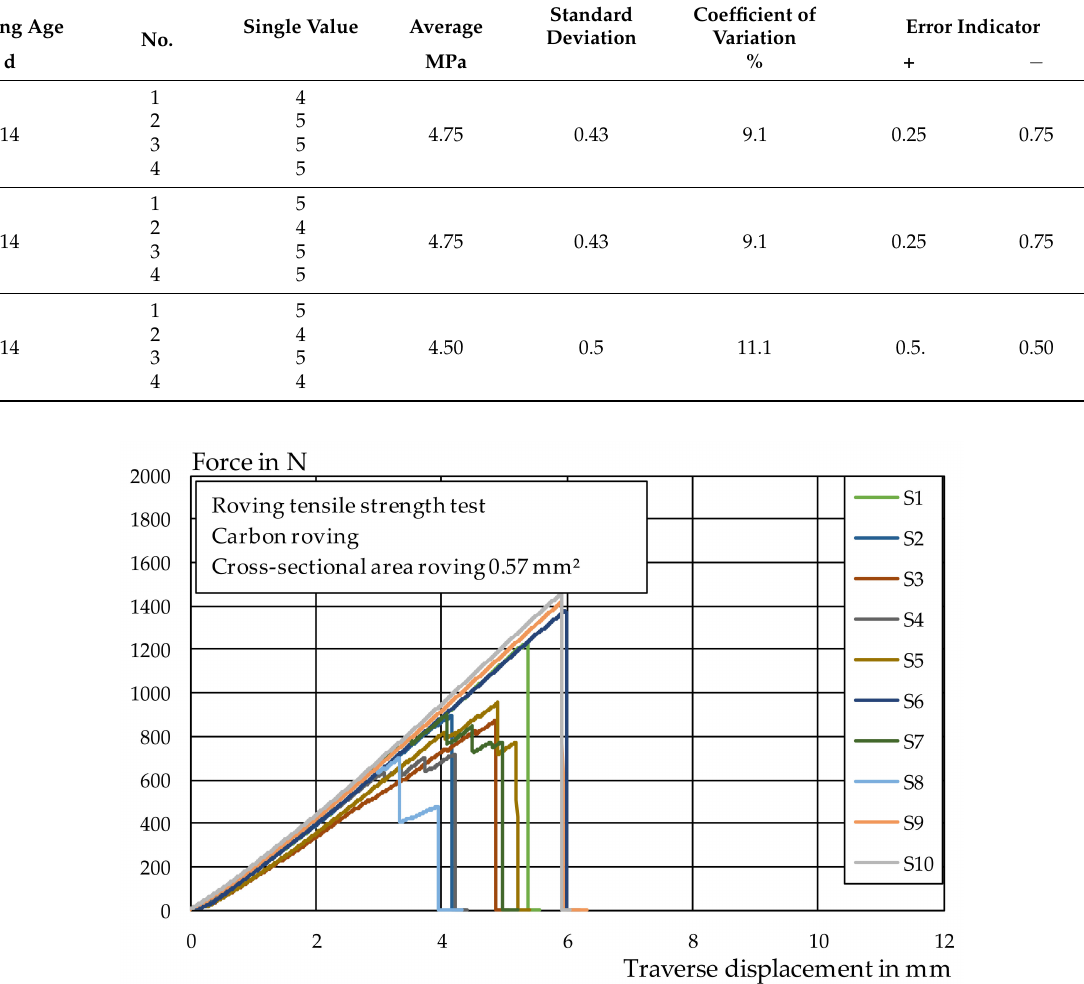
Table A8. Number of cracks, uniaxial tension test, carbon textile, Mortar 1–3.